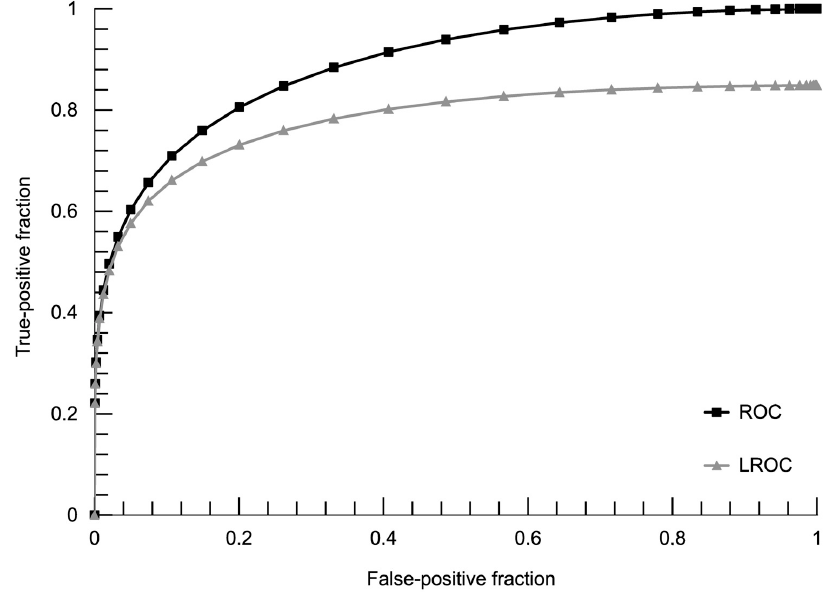
Figure 4. ROC and LROC curves. Calculated ROC and LROC curves were plotted from fit- distribution